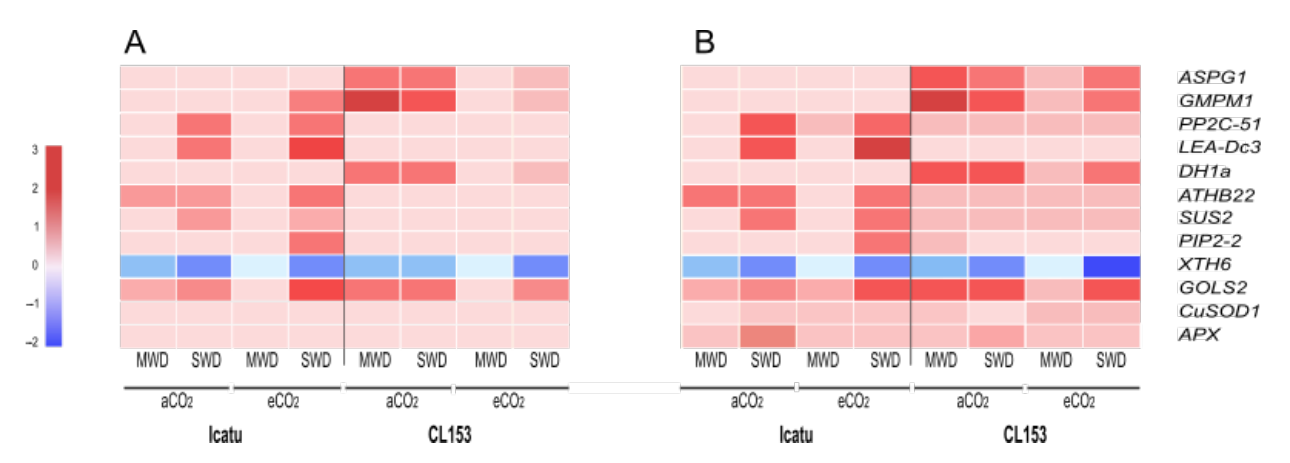
Figure 8. Heatmap of expression levels (log 2 ratio) of the selected genes obtained from RNA-seq ( A ) and validated by qRT-PCR ( B ), considering the effect of MWD or SWD in comparison with WW-Icatu and CL153 plants, grown under aCO 2 (light colors) or eCO 2 (dark colors), at 25/20 °C (day/night). GMPM1 : 18 kDa seed maturation; PP2C-51 : protein phosphatase 2C 51-like; LEA-DC3 : late embryogenesis abundant protein Dc3-like; DH1a : dehydrin DH1a; ATHB22 : homeobox leucine zipper; SUS2 : sucrose synthase 2-like; PIP2-2 : aquaporin PIP2-2-like; XTH6 : xyloglucan endotransglucosylase/hydrolase protein 6; GOLS2 : galactinol synthase 2-like; CuSOD1 : superoxide dismutase [Cu-Zn]; APX Chl : chloroplast ascorbate peroxidase.